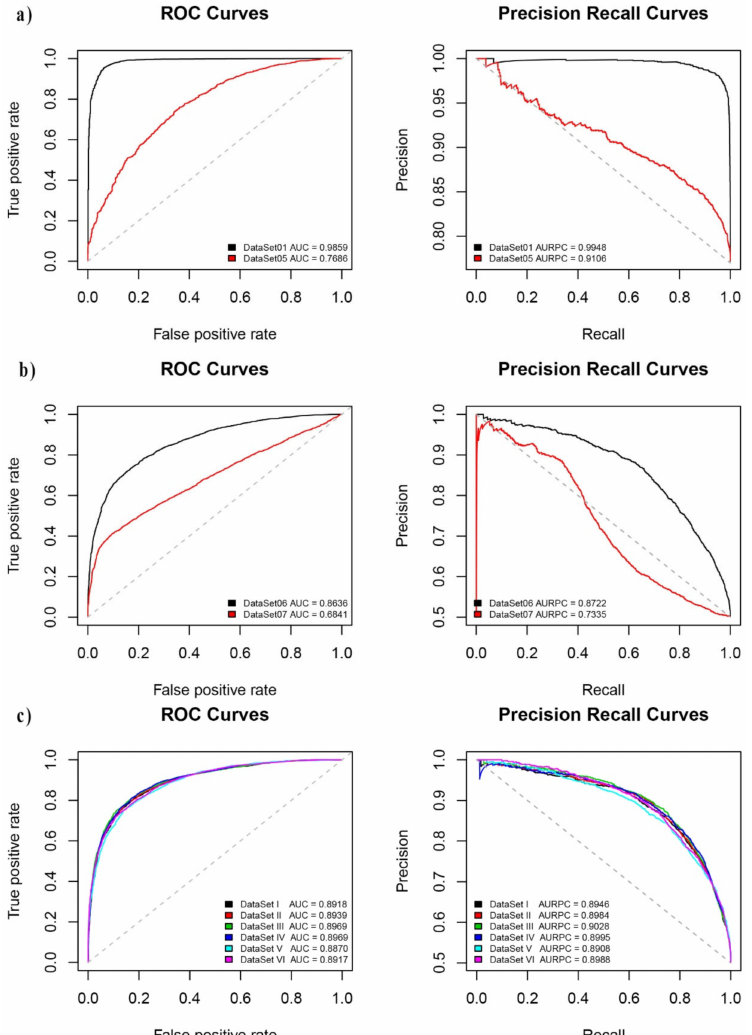
Figure 10. Recall-precision and ROC curves displaying the performance of LightGBM on testing datasets of ( a ) DataSet 01 and DataSet 05, and ( b ) DataSet 06 and DataSet 07 and ( c ) from DataSet I to DataSet VI. Note that the scale of values on the vertical axis is di ff erent from recall-precision curves (0.5–1.) and ROC curves